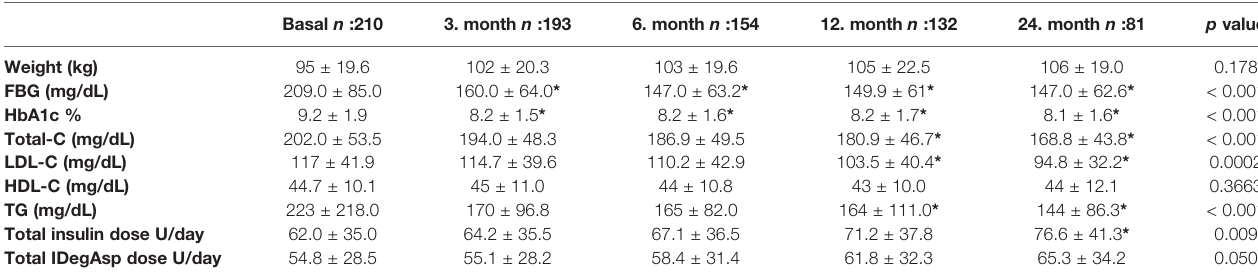
TABLE 1 | Type 2 DM patients ’ insulin requirement and laboratory